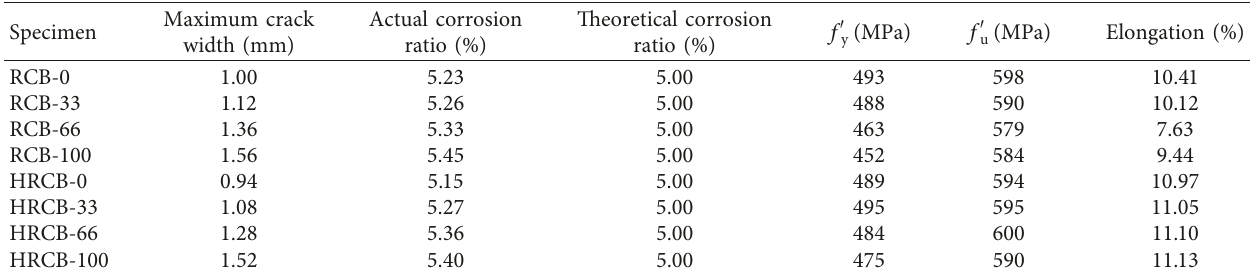
Table 6: Corrosion ratios and mechanical properties of tensile corroded steel bar.